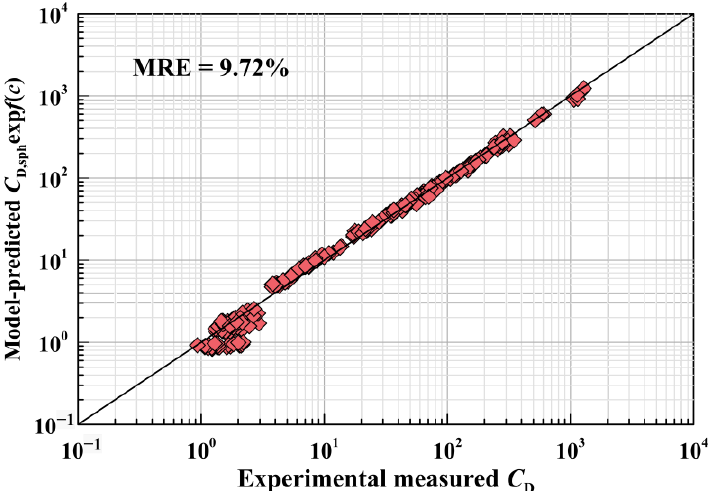
e xp () C f c D , s ph